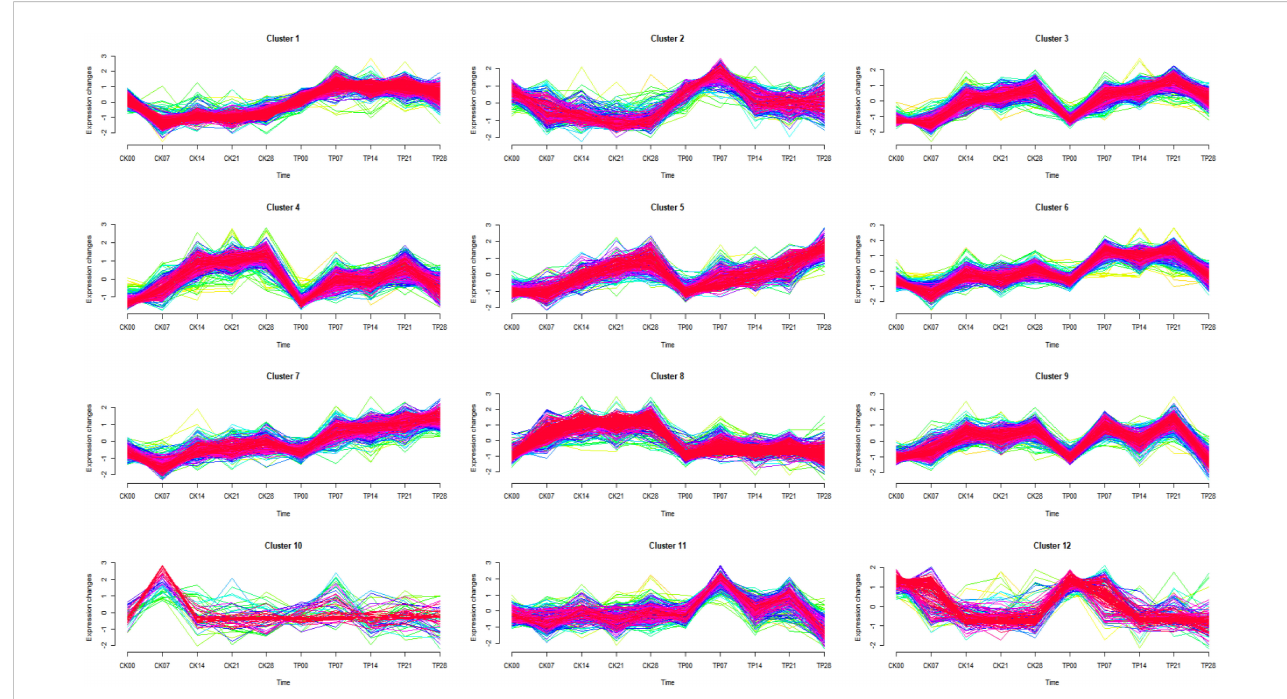
FIGURE 4 Results of the Mfuzz clustering of 3149 differentially expressed proteins identi fi ed by Label-free proteomics based on their expression